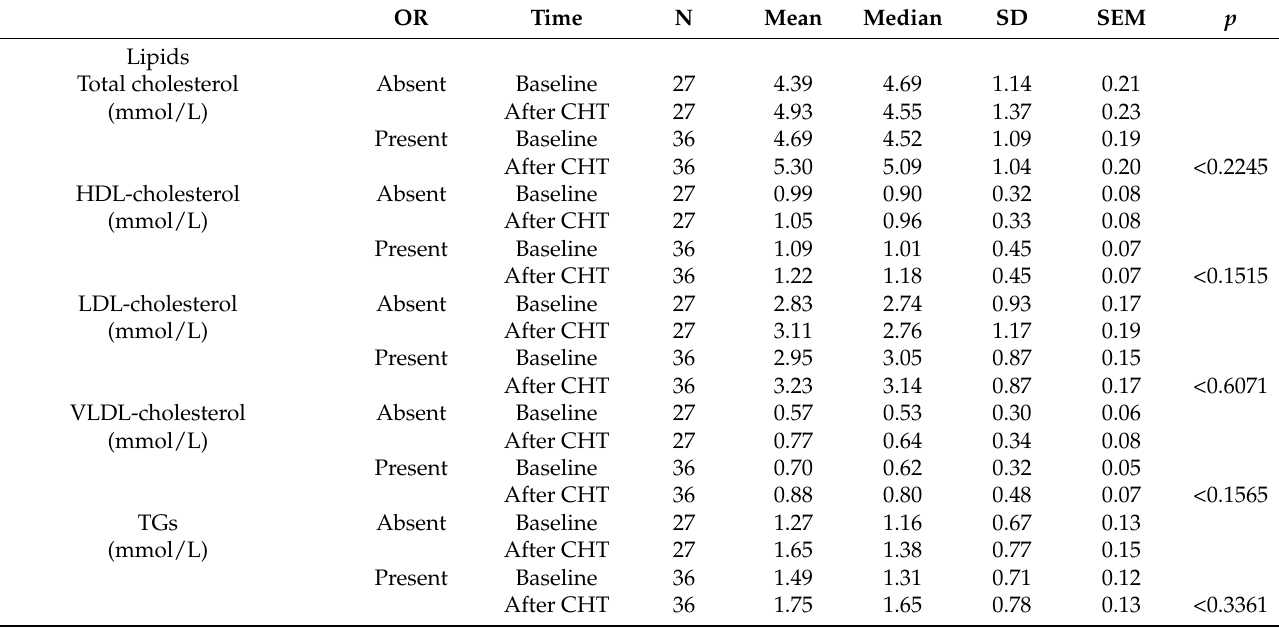
Table 4. Plasma lipids, antioxidants, index CoQ 10-TOTAL /lipids, and oxidative stress baseline vs. after two courses of chemotherapy in metastatic urothelial carcinoma (mUC) patients—a subgroup analysis by objective response (OR). N: number of patients; SD: standard deviation; SEM: standard